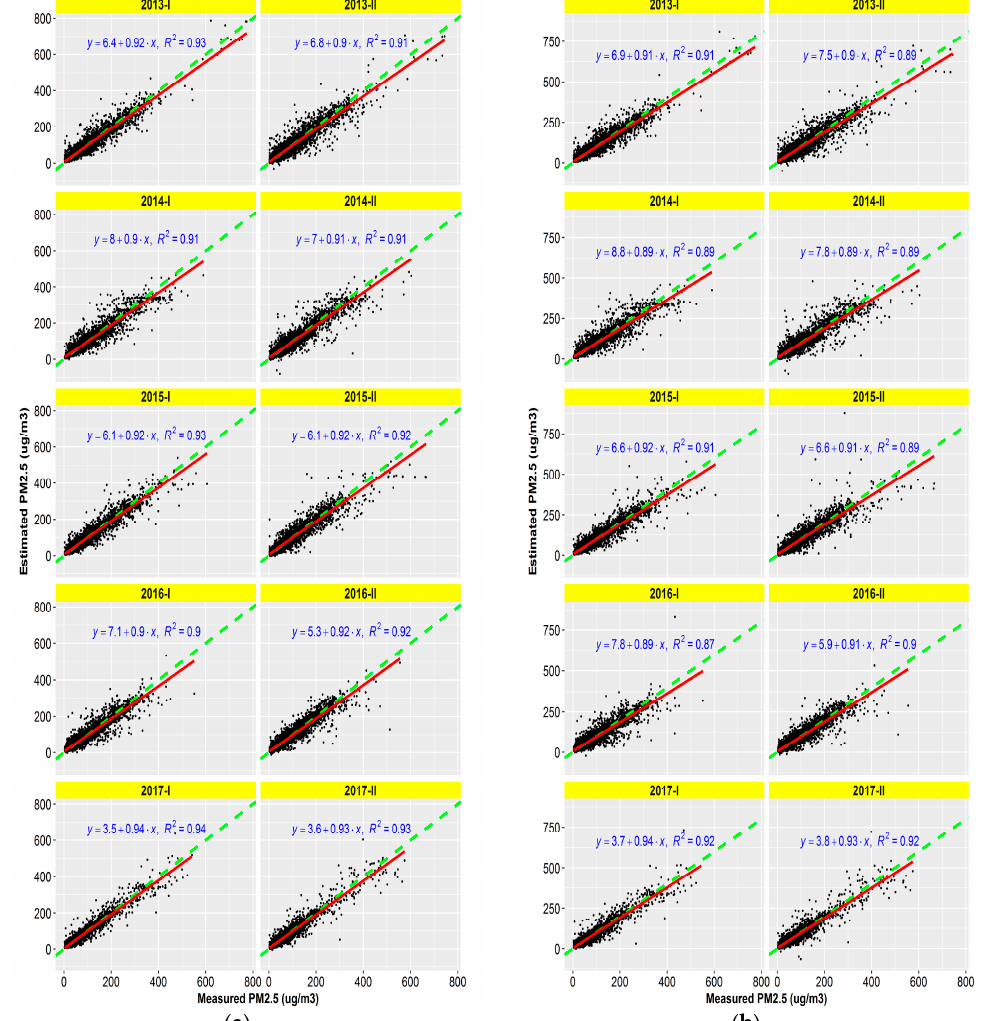
Figure 3. Scatterplots between estimated and measured PM 2.5 levels for each year: ( a ) Model fitting; ( b ) Model cross validation. The red solid line represents the regression line and the green dashed line is the 1:1 line with slope of 1.0; ‘I’ denotes models using the PM 2.5 24 h average, and ‘II’ denotes models using the PM 2.5 period average.